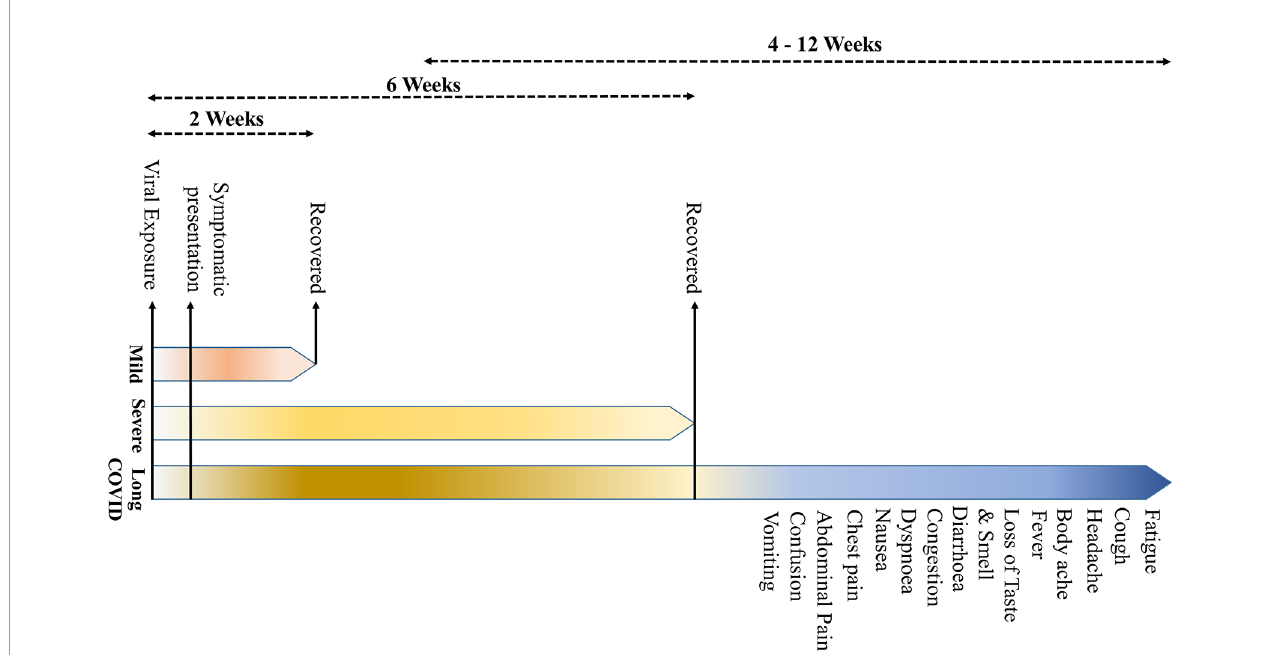
FIGURE 1 | The symptomatology of coronavirus disease 2019 (COVID-19). (The onset of the clinical symptoms occurs in average 5 – 6 days after exposure, and normally, those with mild symptoms recover within 2 weeks; however, in severe cases, the recovery may extend up to 6 weeks. Persistence of the disease or, after complete recovery, emergence of new ailments, together known as “ long COVID ” may occur in some patients. The “ long COVID ” is chie fl y characterized by the presence of fatigue, headache, dyspnea, and anosmia, which may persist for 4 – 12